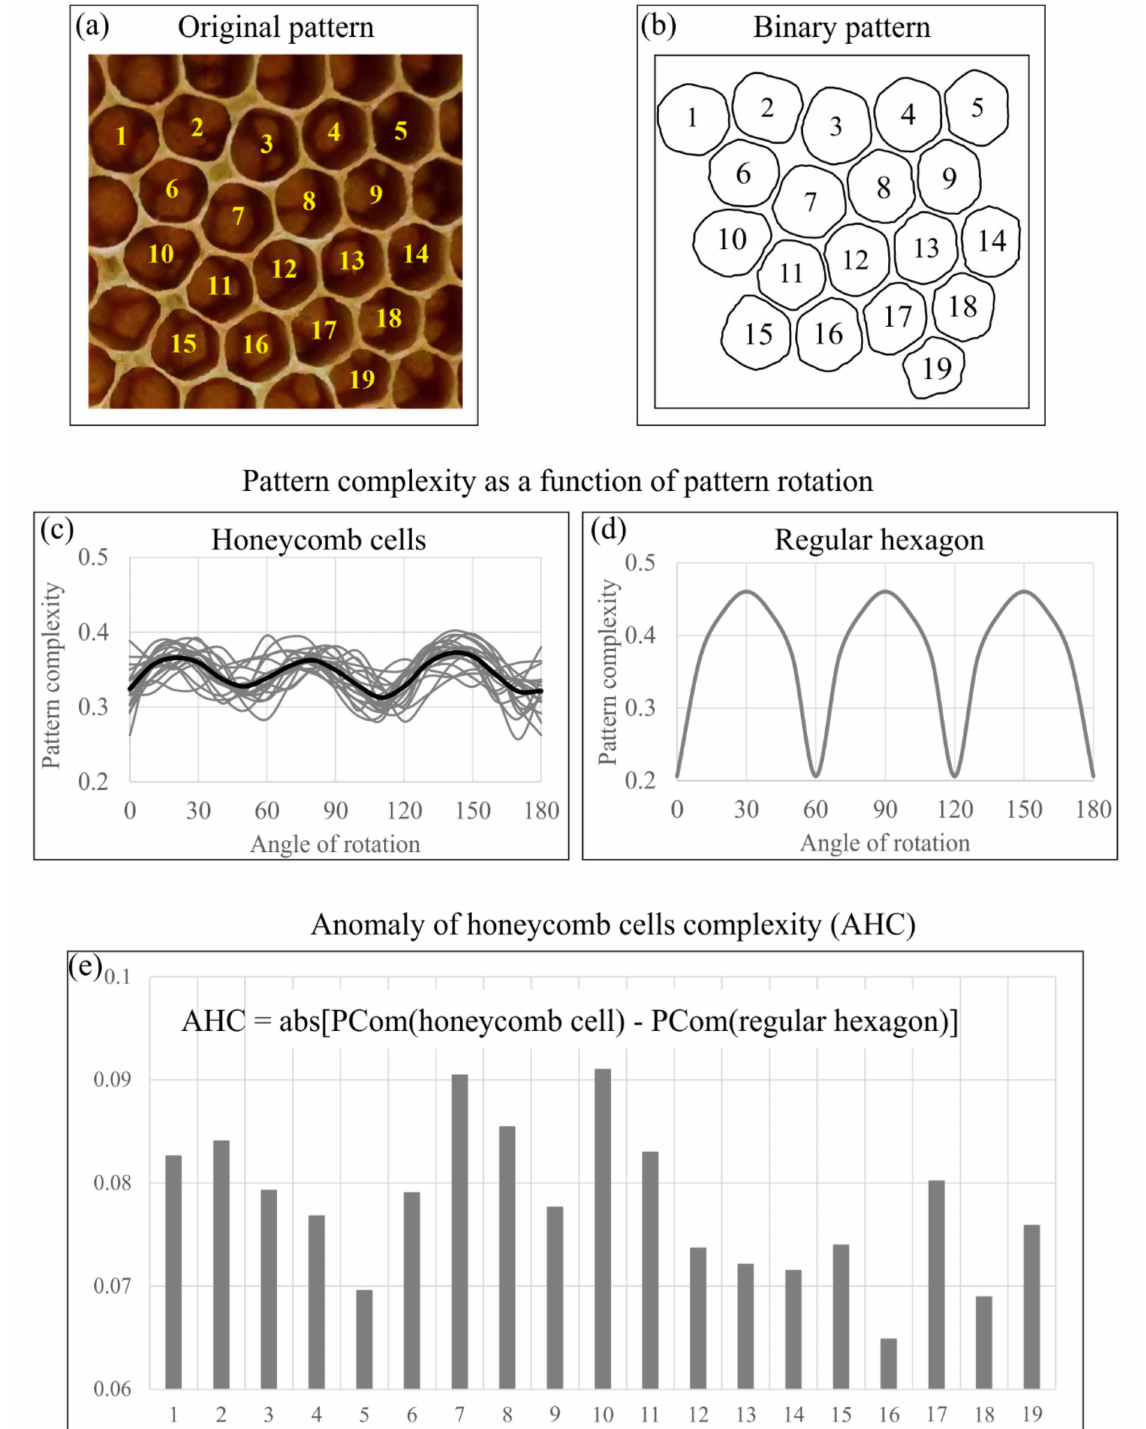
Figure 11. Morphology of hexagonal honeycomb cells. ( a ) Color pattern of hexagonal honeycomb cells. ( b ) Honeycomb cell patterns in binary format. ( c ) Complexity of 19 honeycomb cells as the function of cell rotation. The black line is the result of averaging the complexity of 19 honeycomb cells. The morphology of the black line corresponds with the morphology of the regular hexagon. ( d ) Complexity of a regular hexagon as the function of pattern rotation. ( e ) Anomaly of hexagonal honeycomb cells complexity. Credit: Scientific Reports